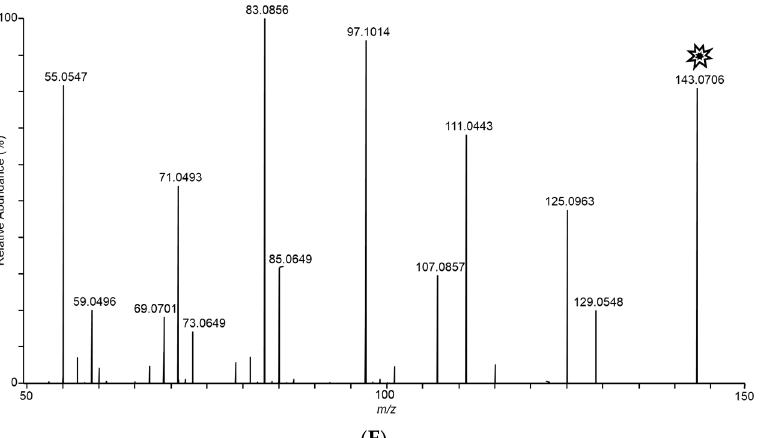
Figure 5. Tandem CID spectra for m/z ( A ) 165 (from F. scirpi ), ( B ) 167 (from F. scirpi ), ( C ) 195 (from F. verticillioides ), ( D ) 153 (from F. verticillioides ), ( E ) 129 (from F. graminearum ), and ( F ) 143 (from F. graminearum ) ions. [M + H] + target ions for the CID experiments are labelled with a “ ” icon. Spectra represent averaging of the 3 min acquisition period for each sample.